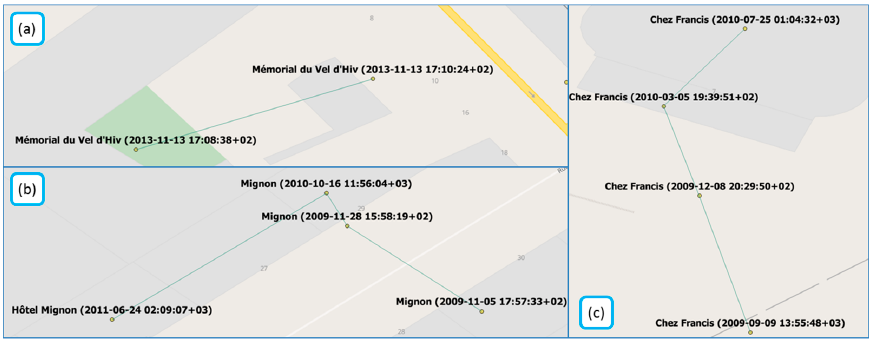
Figure 1. Examples of displacement in OSM POIs (©OpenStreetMap contributors).